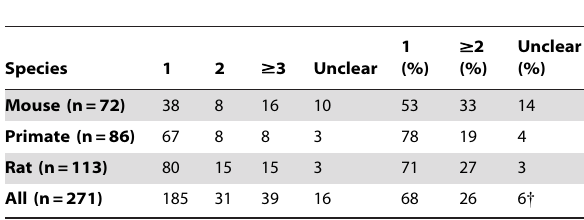
Table 4. Number of experiments reported in each study.